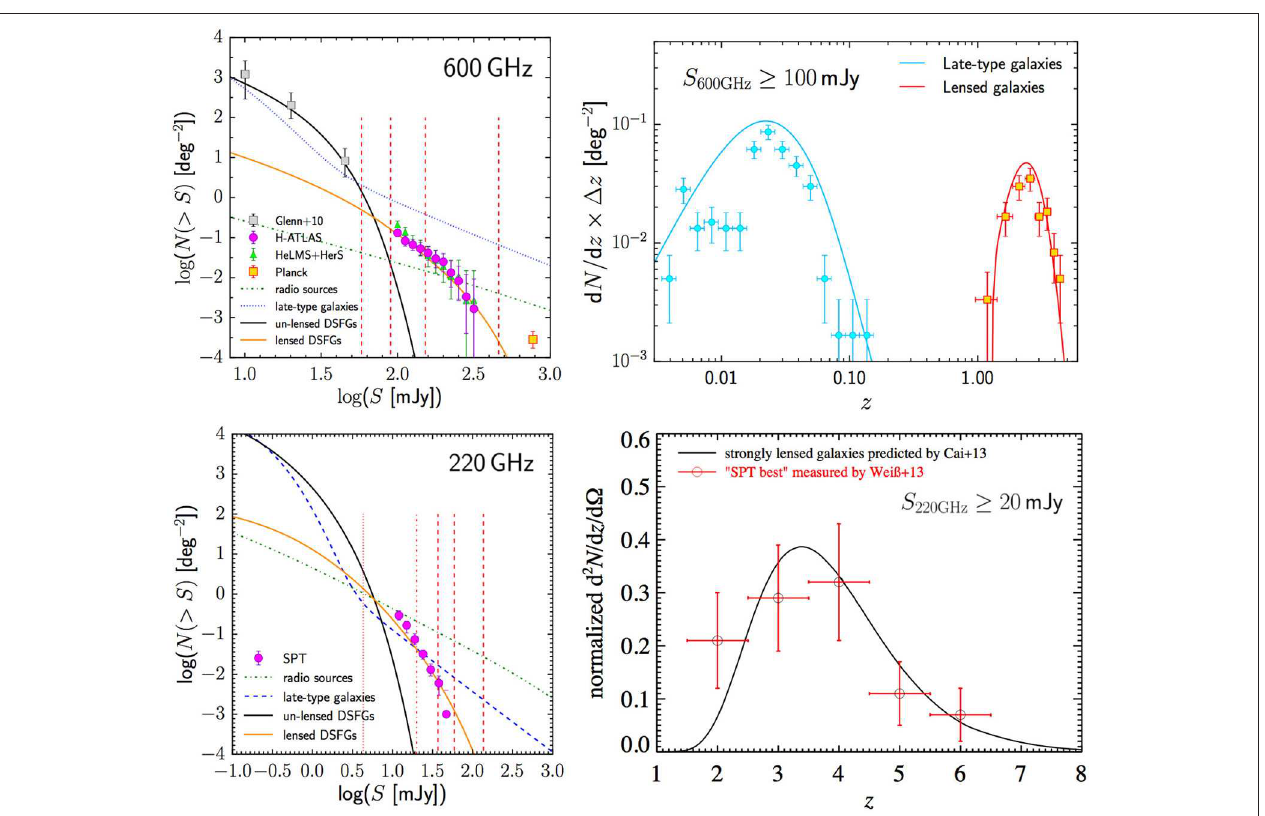
FIGURE 3 | (Upper left panel) Integral counts of strongly lensed galaxies from Herschel surveys at 500 µ m (600 GHz; green and magenta data points from Negrello et al., 2017a), compared with the predictions of the Cai et al. (2013) model (solid orange line). The yellow square on the bottom-right corner is our own estimate of the counts of strongly lensed galaxies detected by Planck . The counts of unlensed proto-spheroidal galaxies (data points from Glenn et al., 2010, black squares; model by Cai et al., 2013, solid black line), of radio sources (dotted green line, model by Tucci et al., 2011) and of normal and starburst late-type galaxies (dotted blue line, model by Cai et al., 2013) are also shown for comparison. The vertical dashed orange lines show, from right to left, the 90% completeness limit of the PCCS2 and the 5 σ detection limits for space-borne CMB experiments with 1, 1.5 and 2m telescopes working at the diffraction limit. This panel shows a modified version of Figure 8 of Negrello et al. (2017a). (Upper right panel) Redshift distribution of galaxies brighter than 100mJy at 500 µ m, derived from the full H-ATLAS catalog (data points with Poisson errors) compared with the predictions of the Cai et al. (2013) model (solid lines). There is a clear bimodality. On one side we have nearby late-type galaxies, almost all at z ≤ 0.06, and hence easily recognizable in optical/near-infrared catalogs. On the other side we have dust enshrouded, hence optically very faint, gravitationally lensed galaxies at z ≥ 1 and up to z > 4. (Lower left panel) Integral counts of strongly lensed galaxies from the SPT survey at 220GHz (1.4mm; magenta data points; Vieira et al., 2010) compared with the prediction of the Cai et al. (2013, orange solid line) model. Counts of radio sources and of late-type galaxies are from the same models as in the upper panel . The vertical lines show, from right to left, the 5 σ detection limits for diffraction limited 1, 1.5, and 2m telescopes, the completeness limit of the SPT survey (Mocanu et al., 2013) and the 5 σ confusion limit for a 6m telescope. (Lower right panel) Estimated redshift distribution of strongly lensed galaxies with S 220GHz > 20mJy ( Weiß et al., 2013) compared with the prediction of the Cai et al. (2013)